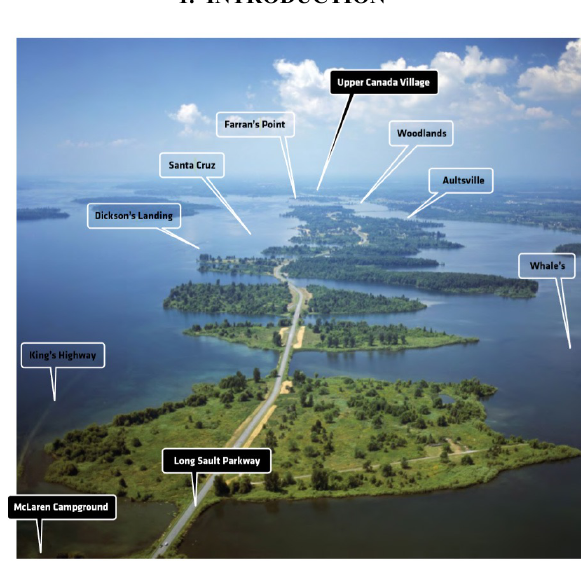
Figure 1. Image of St.Laurence